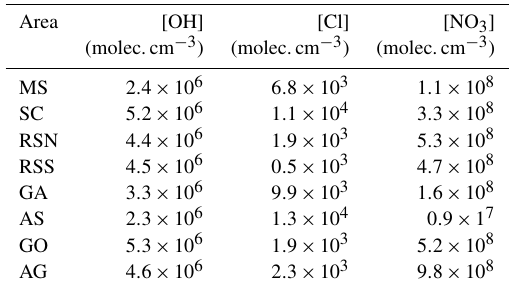
Table 4. Spatial average OH and Cl concentrations simulated by MOM.